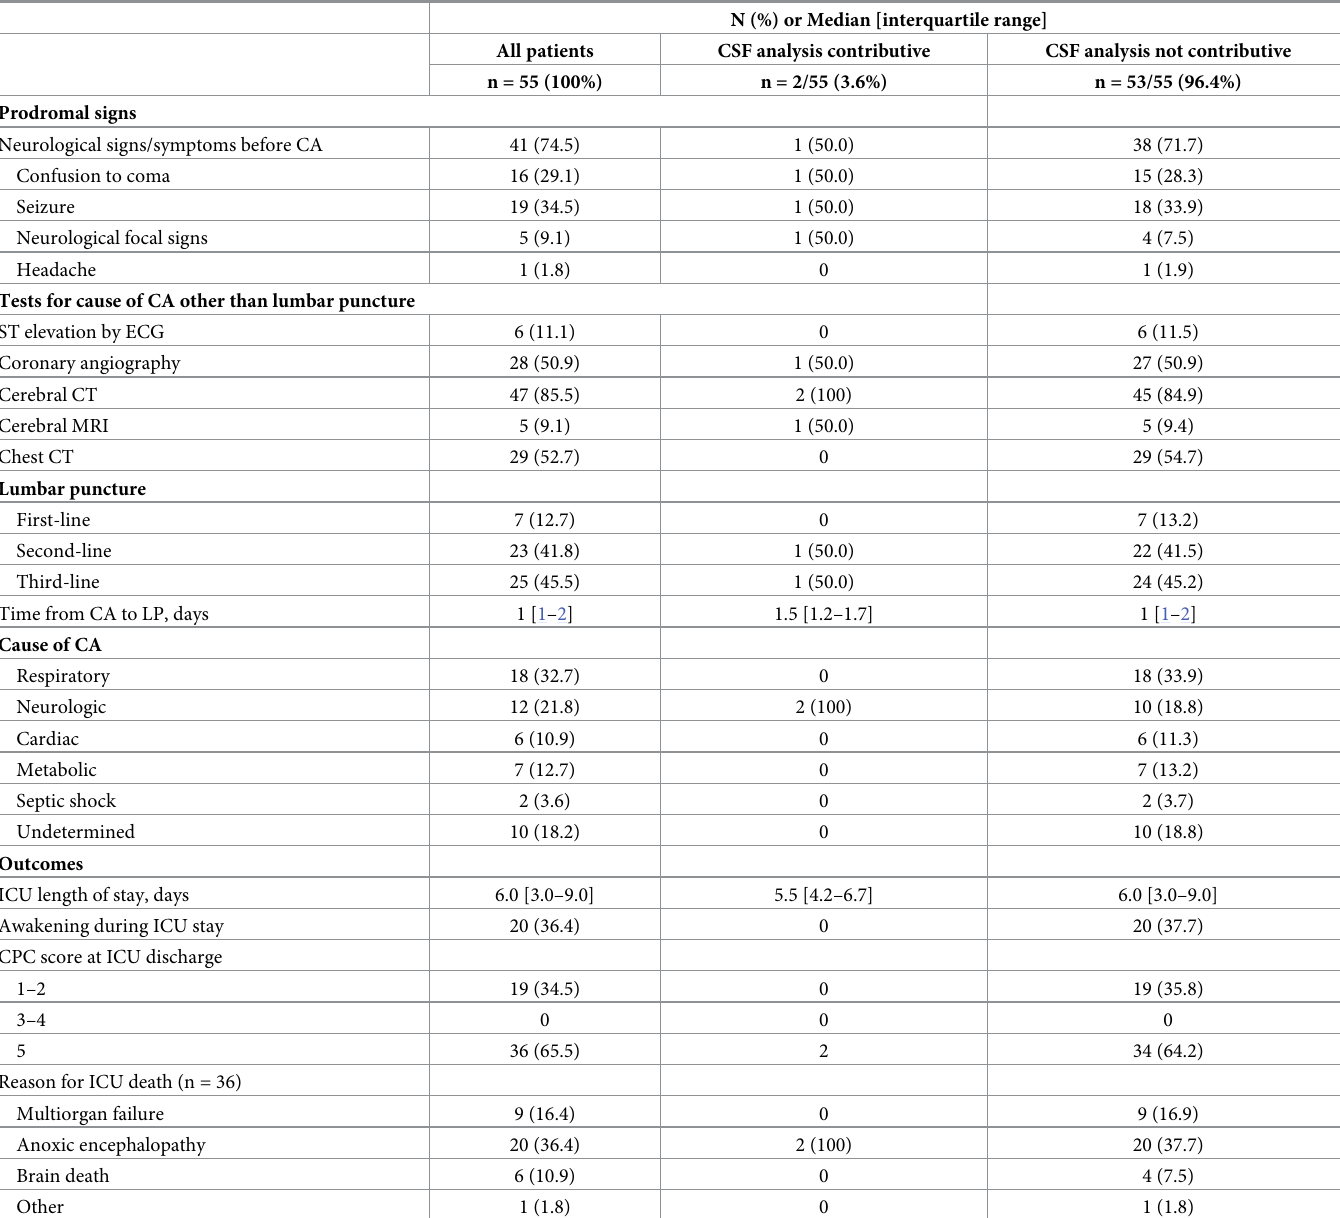
Table 1. Diagnostic workup, identified causes, and outcomes in 55 patients who underwent lumbar puncture after cardiac arrest. N (%) or Median [interquartile range] All patients CSF analysis contributive CSF analysis not